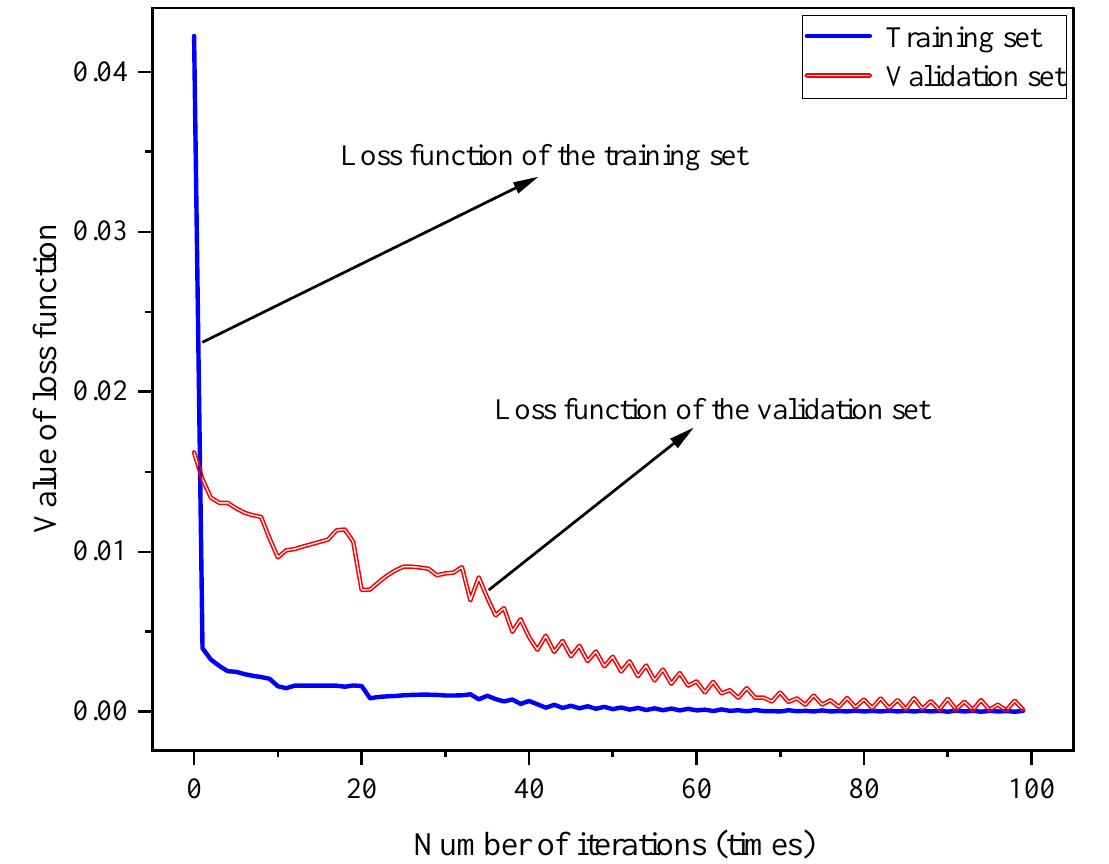
Figure 19. The loss-function